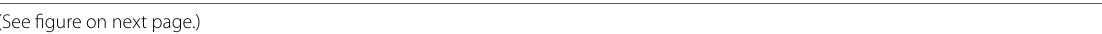
figure on next Fig. 4 TA inhibits Aβ(1–42)‑induced activation of the NLRP3 inflammasome through the AMPK/ULK1‑ and Raf/MEK/ERK‑mediated autophagy. A , B BV‑2 cells were pretreated with 5 μM of Aβ (1–42) for 12 h, followed by the treatment of TA (10 μM) in the presence or absence of CC (10 μM) or SCH (20 μM) for an additional 24 h. Then protein expressions were detected using Western blot. Bar charts indicate the ratios of NLRP3/β‑actin, ASC/β‑actin, caspase‑1 (p10)/pro‑caspase‑1, IL‑1β (p17)/pro‑IL‑1β, IL‑18 (p18)/pro‑IL‑18, and GSDMD (p30)/pro‑GSDMD in BV‑2 cells. B Error bars, S.D. * p 0.05; ** p 0.01; *** p 0.001, n 3. (One‑way ANOVA with Tukey‑corrected post hoc t ‑tests for multiple comparisons was applied for ≤ ≤ ≤ = comparison between groups). The full‑length blots are presented in Additional file 1: Fig.